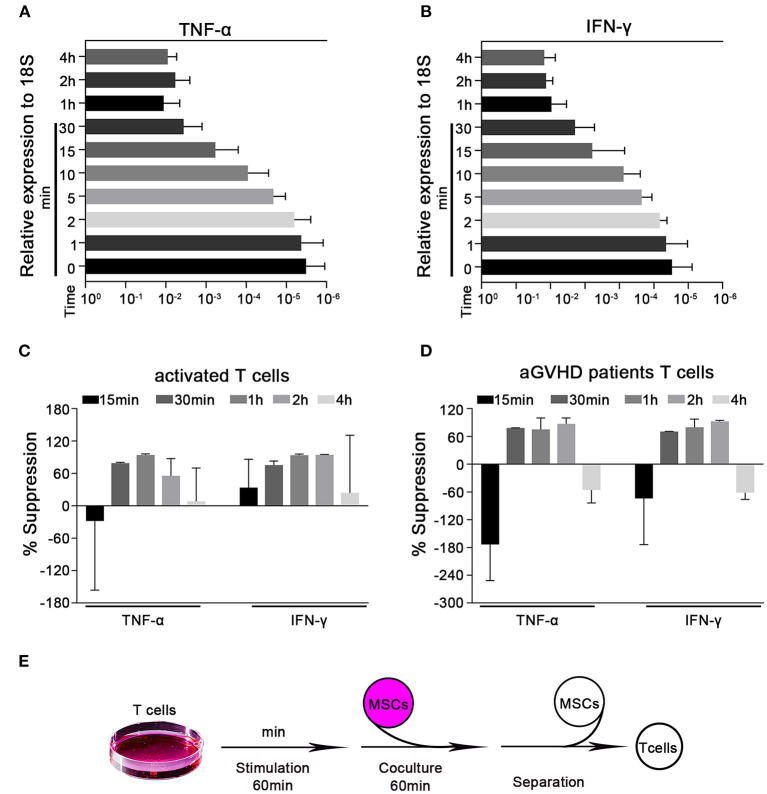
MSCs rapidly suppress the transcription of cytokines in activated T cells. Quantitative reverse transcription–polymerase chain reaction (qRT-PCR) analysis of the mRNA abundances of TNF-α and IFN-γ in activated T cells. (A,B) T cells were stimulated by CD3 mAb and CD28 mAb for 1, 2, 5, 10, 15, and 30 min, 1, 2, and 4 h. The mRNA abundances of TNF-α and IFN-γ were analyzed, the results are presented relative to the level of the 18S rRNA. (C) Activated T cells from healthy donors were cocultured with MSCs (ratio 5:1) for 15 and 30 min, 1, 2, and 4 h. The T cells were then isolated and analyzed for the mRNA levels of the indicated cytokines, which are shown as the percentages of suppression relative to the corresponding levels in monocultured T cells. (D) T cells from pediatric aGVHD patients were treated as described in (C), but without activation. The results are shown as the percentages of suppression by MSCs for the indicated cytokines. (E) Schematic of the experimental protocol: T cells were stimulated for 60 min, cocultured with MSCs for 60 min (ratio 5:1), and then isolated for subsequent experiments. All experiments were repeated three times. Data are expressed as the means ± SEM from three donors (A–C) or four patients (D).